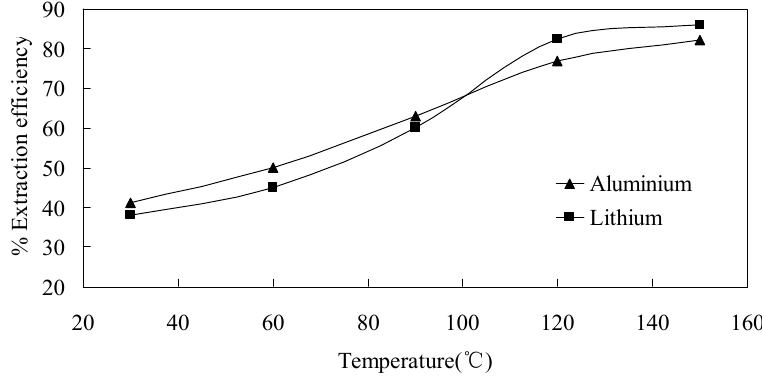
Figure 8. Effect of temperature on the acid leaching of DCFA (6 mol/L HCl, S/L ratio of 1/20, 4 h).